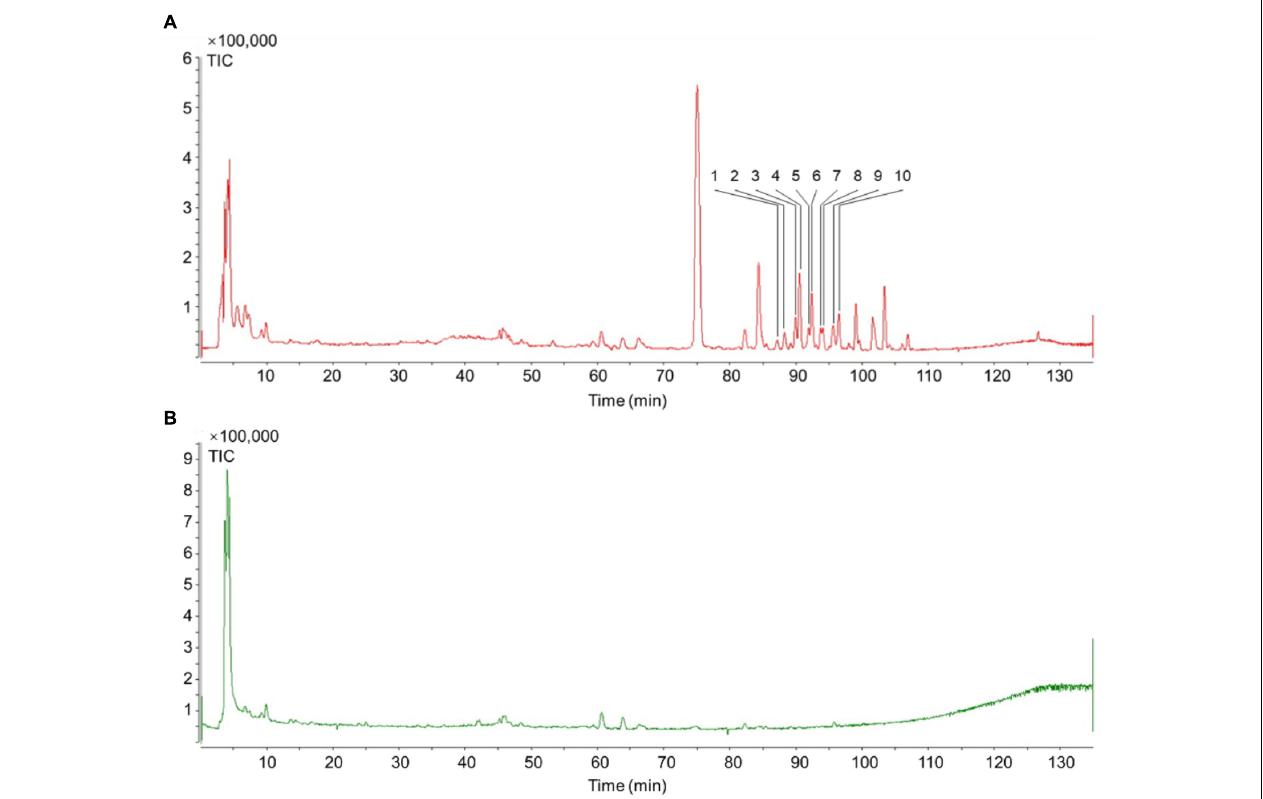
FIGURE 3 | TIC of Schisandra extracts by HPLC-Q-TOF-MS-MS. (A) Positive ion mode MS spectra of SchisandraSchisandra chinensis; (B) Negative ion mode MS spectra of SchisandraSchisandra